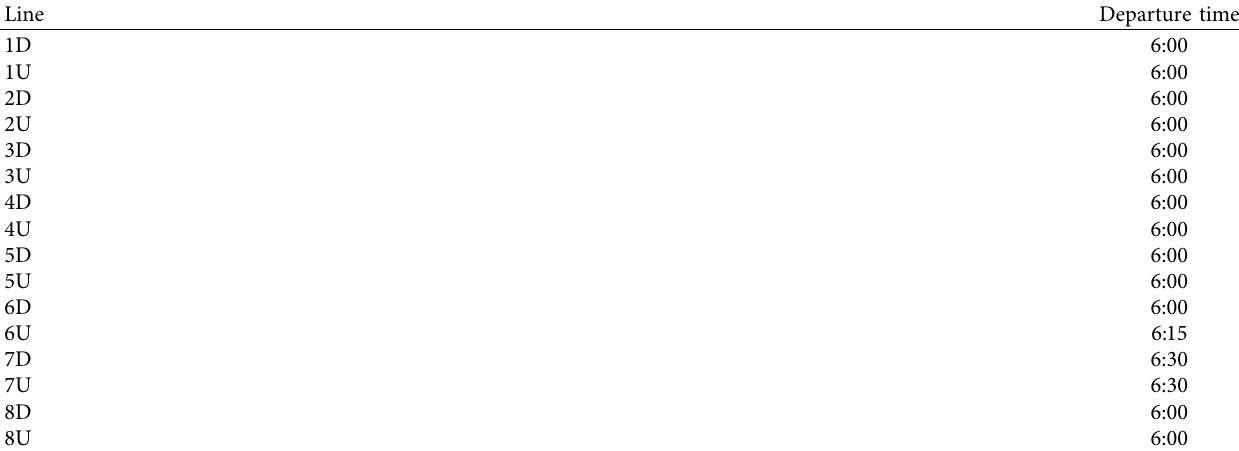
Table 5: Departure times of the first trains in the actual